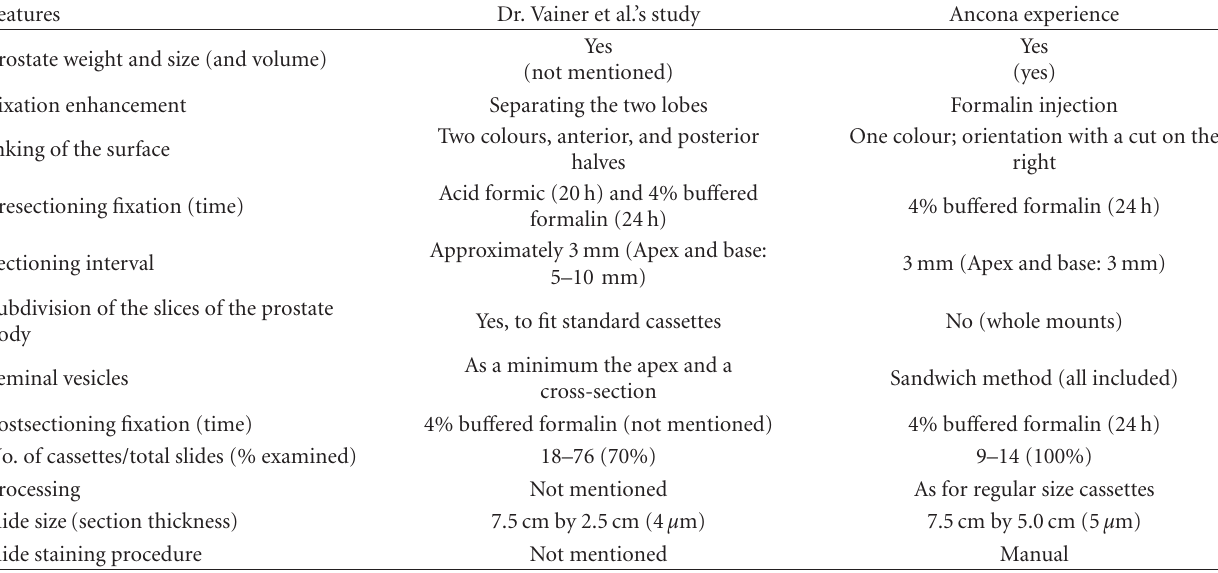
Figure 1: Complete sampling with the whole-mount technique of a prostate specimen. Hematoxylin and eosin-stained sections of prostate specimen are shown on the left and the corresponding mapping on the right. The dotted areas on the slides and the black areas of the map represent two prostatic cancer foci, the index tumour being present on the left of the slides. Extraprostatic extension (EPE) and positive surgical margin (SM+) are present in the posterolateral aspect of the body of the prostate and in one of the slides of the base (see details in the separate images) (SV: seminal vesicles). Table 1: Comparison between Dr. Vainer et al.’s study [8] and Ancona experience